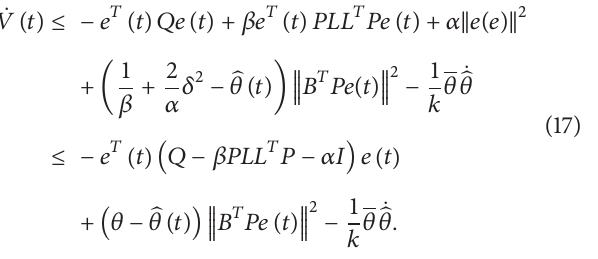
Figure 2 discloses the state trajectories of the error